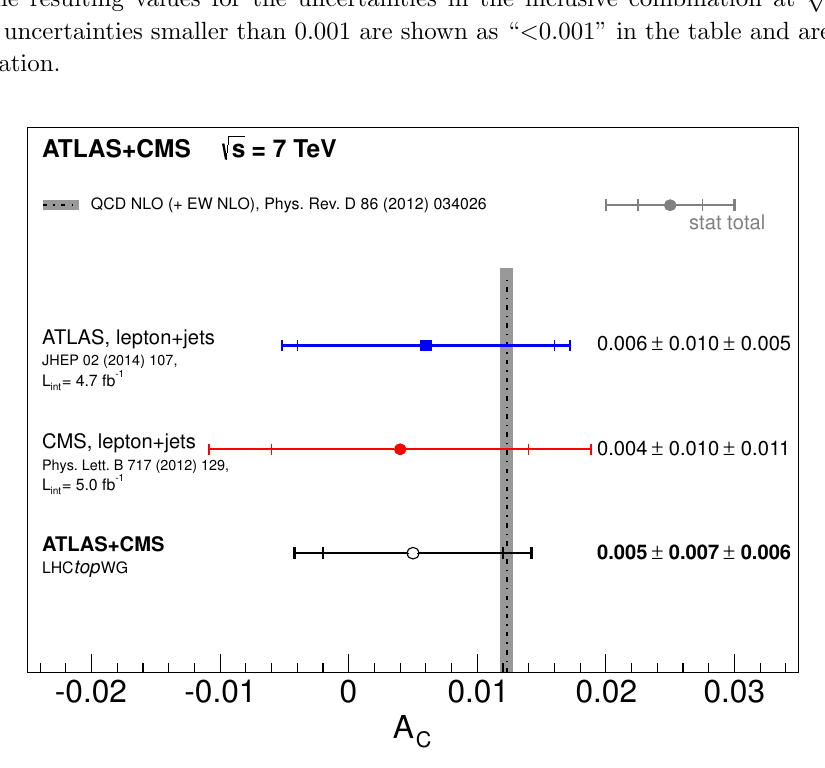
Figure 1 . Summary of the single inclusive measurements and the LHC combination at compared to the theoretical prediction calculated at NLO precision in the strong coupling constant (including NLO electroweak corrections). The inner bars indicate the statistical uncertainty, while the outer bars indicate the total uncertainty. The uncertainty in the theoretical prediction is dominated by uncertainties due to scale